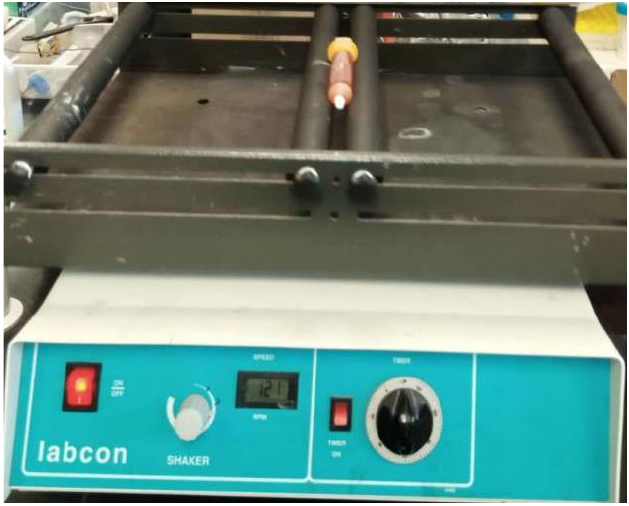
Figure 2. Shaking during the reaction of Fmoc Rink-Amide linker/COMU/DIEA.